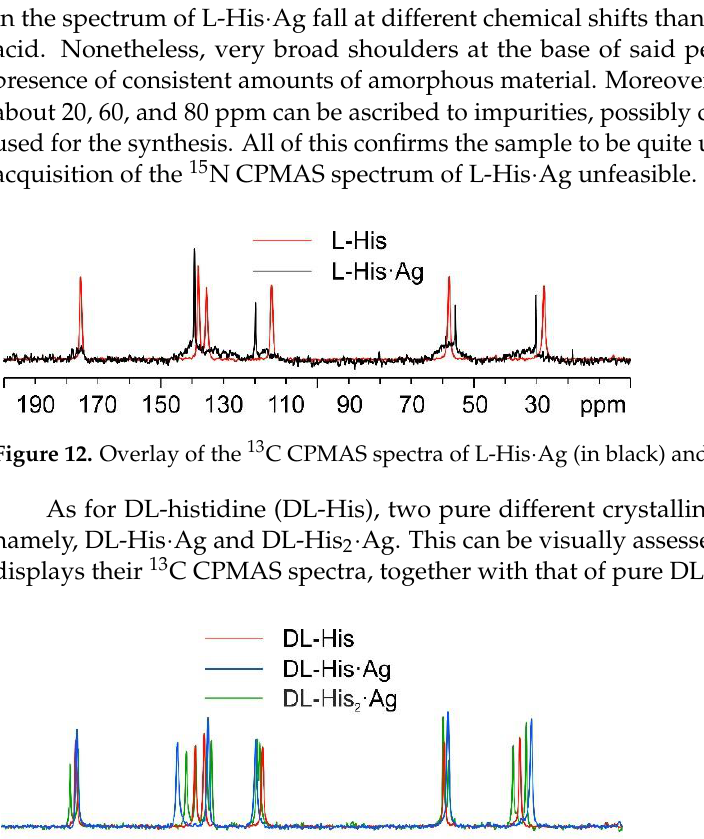
Figure 11. Overlay of a detail of the 15 N CPMAS spectra of L-His 2 ·Ag (in purple) and pure L-His (in red).